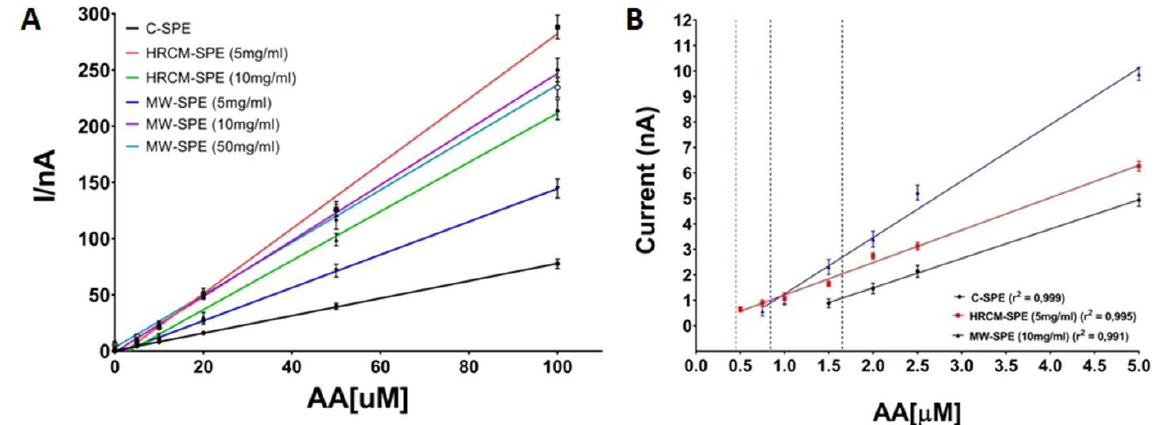
Figure 6. ( A ) Five-point calibration in PBS with 5, 10, 20, 50, and 100 µM AA performed with C-SPEs, MW-SPEs (functionalized with 5, 10, and 50 mg/mL MWCNTs/DMF), and HRCM-SPEs (functionalized with 5 and 10 mg/mL HRCM/DMF). ( B ) Height-points calibration in PBS with 0.25, 0.5, 0.75, 1, 1.5, 2, 2.5, and 5 µM AA performed with C-SPEs, HRCM-SPEs (functionalized with 5 mg/mL HRCM/DMF), and MW-SPEs (functionalized with 10 mg/mL MWCNTs/DMF). All calibrations were baseline subtracted (AA current minus baseline current). An r 2 value is reported for all calibration lines. Vertical, dashed lines correspond to the LOQ (3 × LOD) of different SPEs: black line at x = 1.65 µM for C-SPE; red line at x = 0.45 µM for HRCM-SPE; blue line at x = 0.84 µM for MW-SPE. Points outside the linearity range are not displayed on the graph.